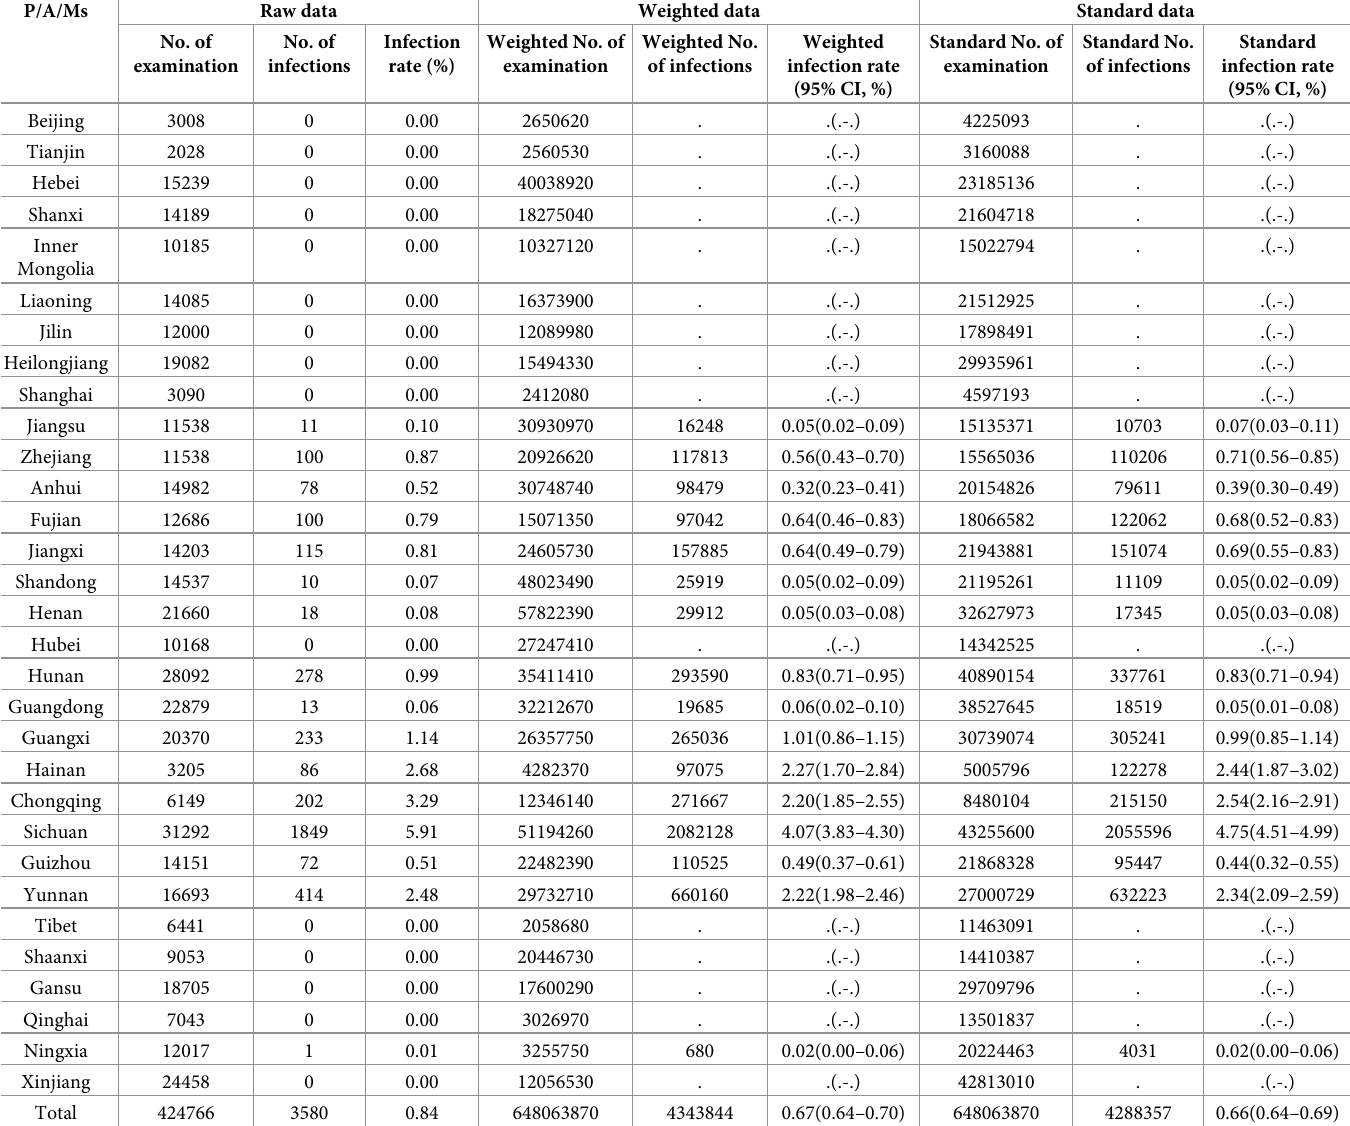
Table 1. Distribution of hookworm infections in different P/A/Ms in 2019 according to the national